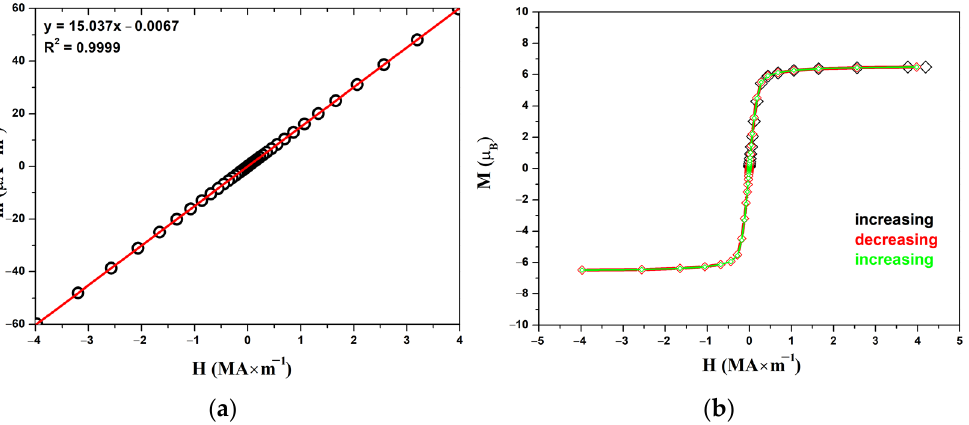
Figure 7. Field-dependent magnetic moments for EuScCuSe 3 at 300 K ( a ) and magnetization curve at 2 K ( b